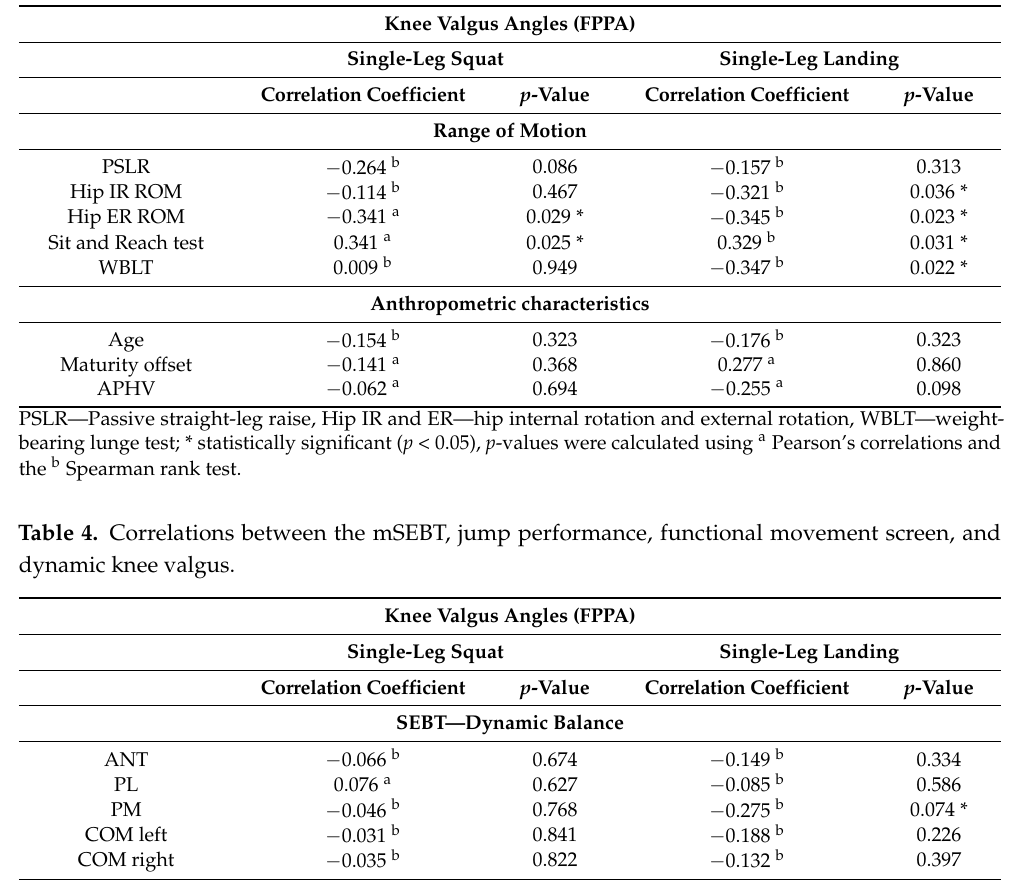
Table 3. Correlations between the range of motion, anthropometric characteristics, jump performance, and knee valgus in the FPPA. PSLR—passive single-leg raise, hip IR—hip internal rotation, hip ER— hip external rotation, WBLT—weight-bearing lunge test; * and bold—statistically significant ( p < 0.05), p -values were calculated using the a Pearson’s correlations and b Spearman Rank test.